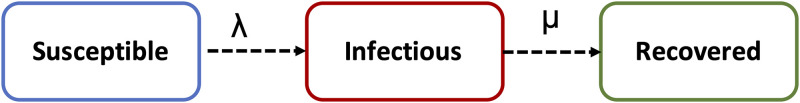
An Illustration of the underlying states of the Susceptible-Infectious-Recovered Model(SIR).